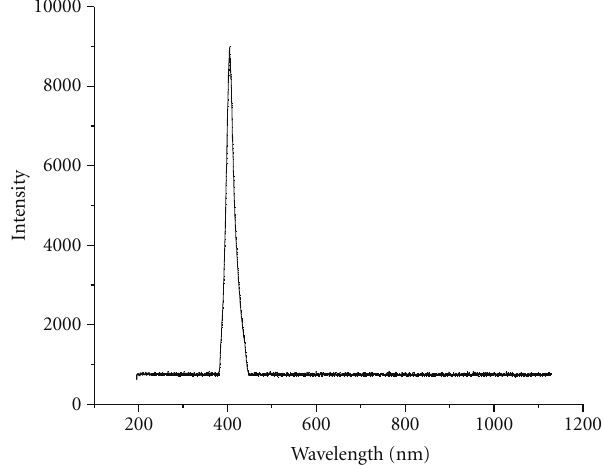
Figure 1: The emission spectra of the blue